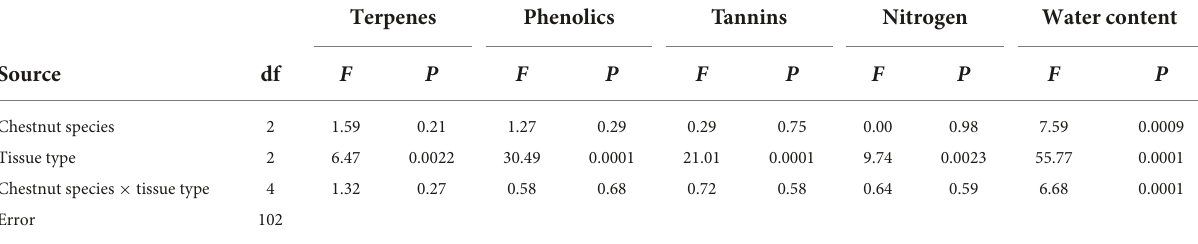
TABLE 2 ANOVA results testing for patterns in the foliar chemistry of three tissue types (ungalled leaf, gall, ungalled portion of galled leaf) in each of three chestnut species.